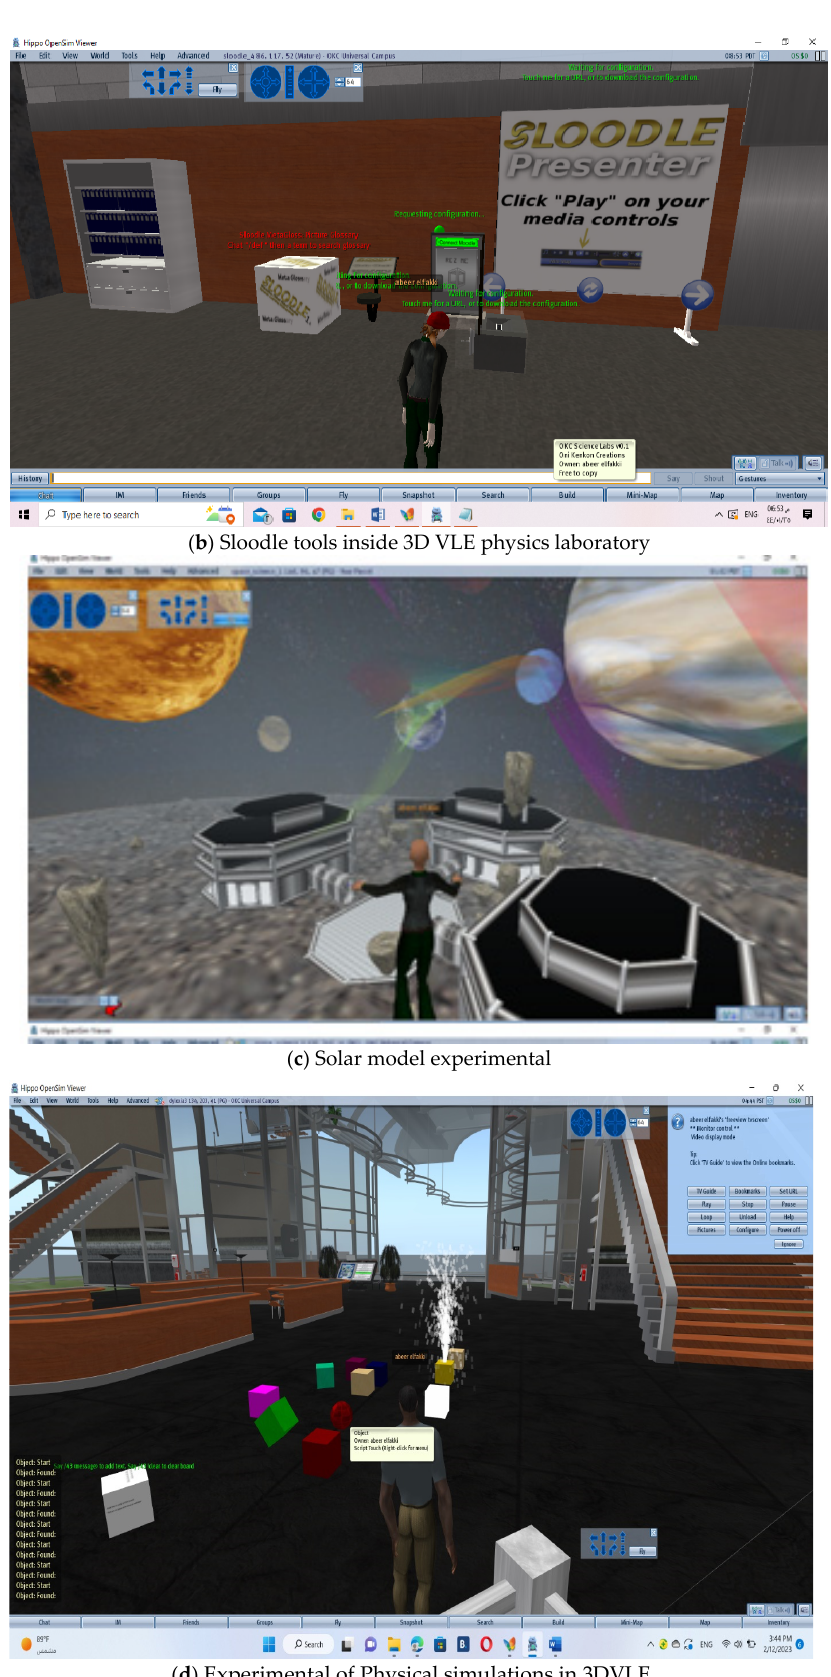
Figure 3. Experimental examples of proposed